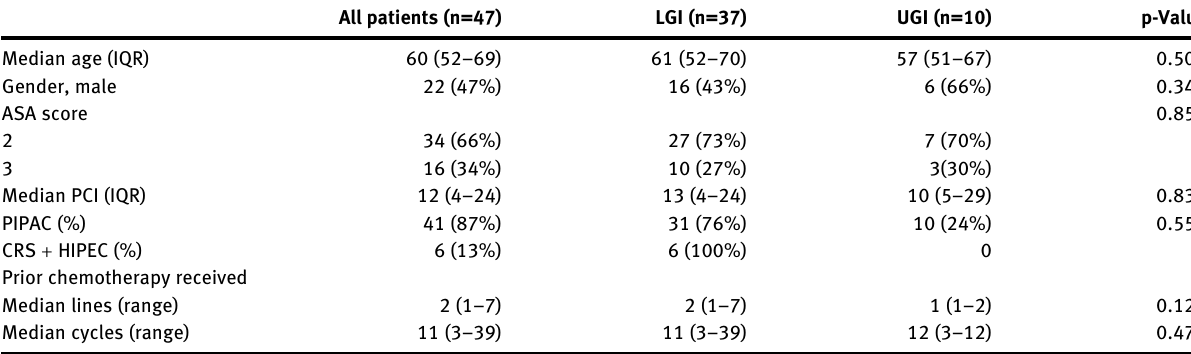
Table  : Patients baseline